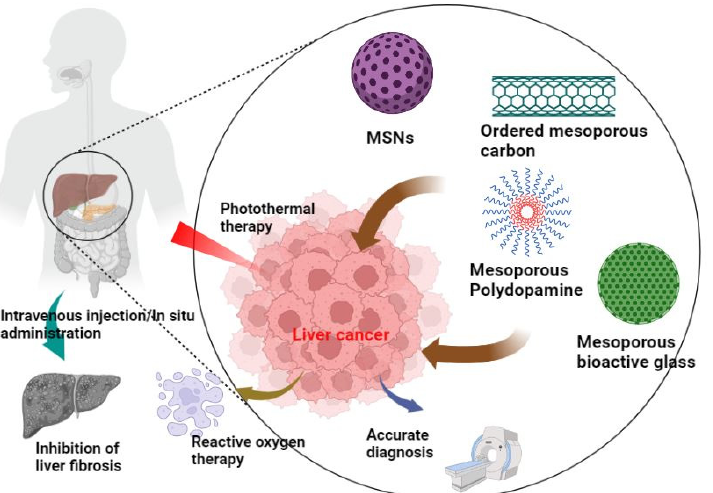
Figure 1. Summary scheme of mesoporous materials for the diagnosis and treatment of liver cancer.